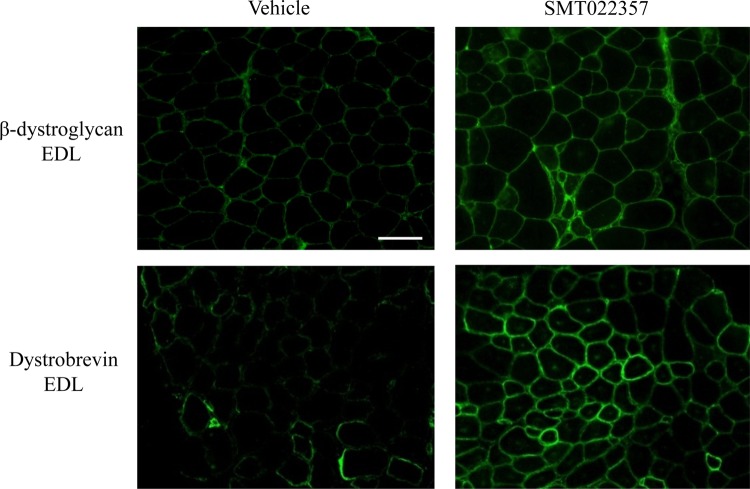
SMT022357 treatment improves fibre membrane stability. Immunofluoresence staining for β-dystroglycan, and dystrobrevin in EDL muscle of 7 weeks old mdx mice treated for 5 weeks with 30 mg/kg/day SMT022357 or vehicle shows that key components of the DAPC complex are properly localised to the sarcolemma after SMT022357 treatment. n = 3 per group; Scale bar: 100 µm.